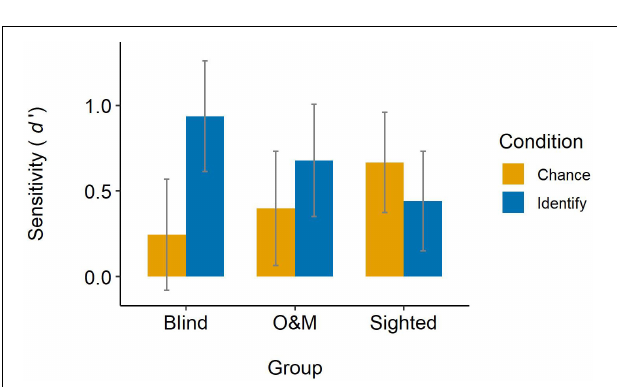
FIGURE 4 | Judges’ sensitivity across groups and conditions. Error bars represent 95% confidence